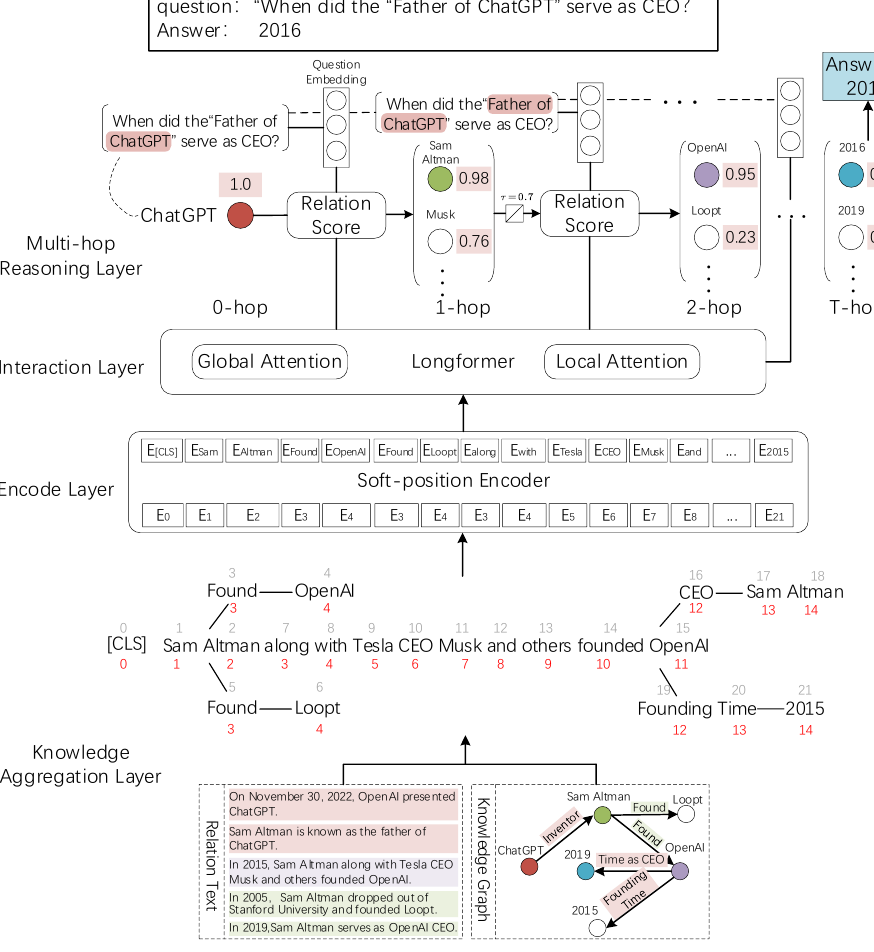
Figure 3. RKE-KGQA model structure diagram. The diagram has a knowledge aggregation layer, an encoding layer, a text interaction layer, and a multi-hop reasoning layer. encoding layer, a text interaction layer, and a multi-hop reasoning